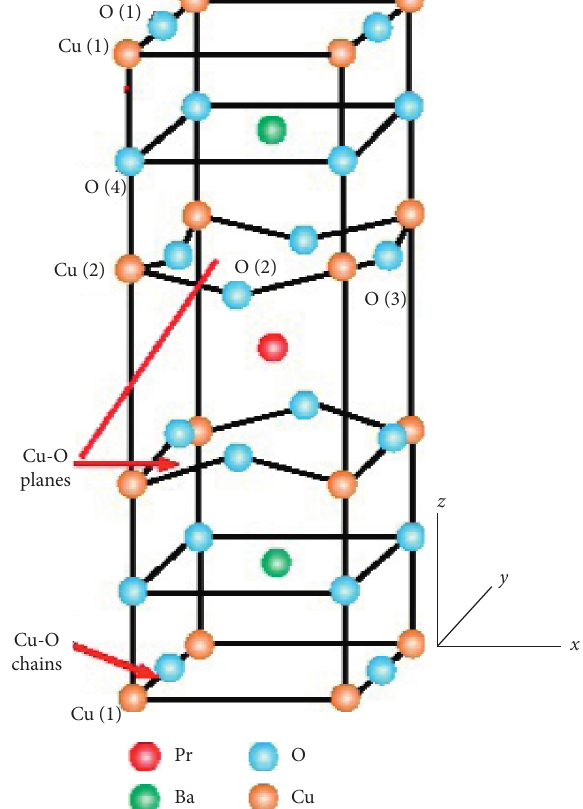
Figure 1: A unit cell of PrBa